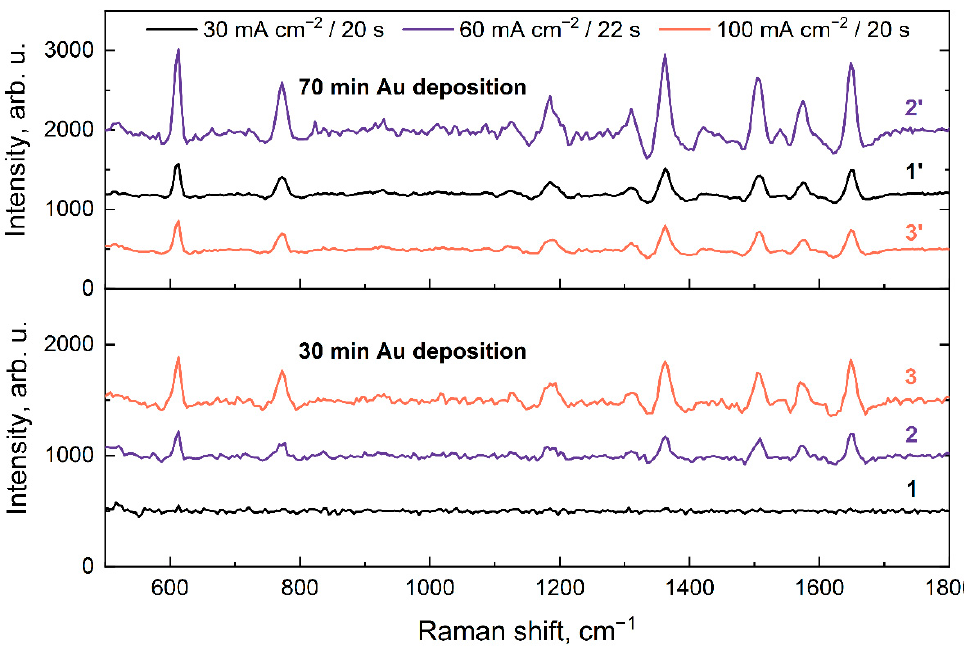
Figure 10. SERS spectra for 10 − 6 M R6G on the gold-coated meso-PS substrates.